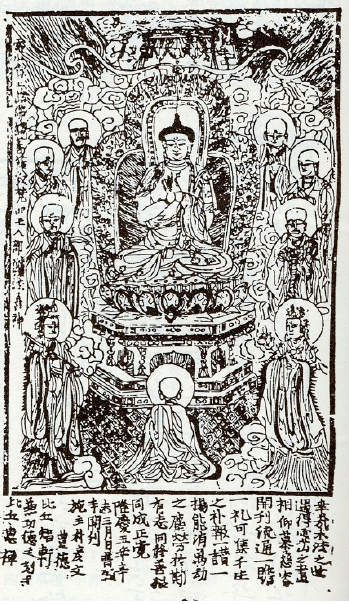
Figure 8. Assembly at Vulture Peak (K. Yeongsan selbeopdo ), Woodblock carved at Bowonsa Temple, Joseon (1571), 26.0 × 17.5 cm, Gaesimsa Temple, Seosan. Source: (Park 1987, p. 190).